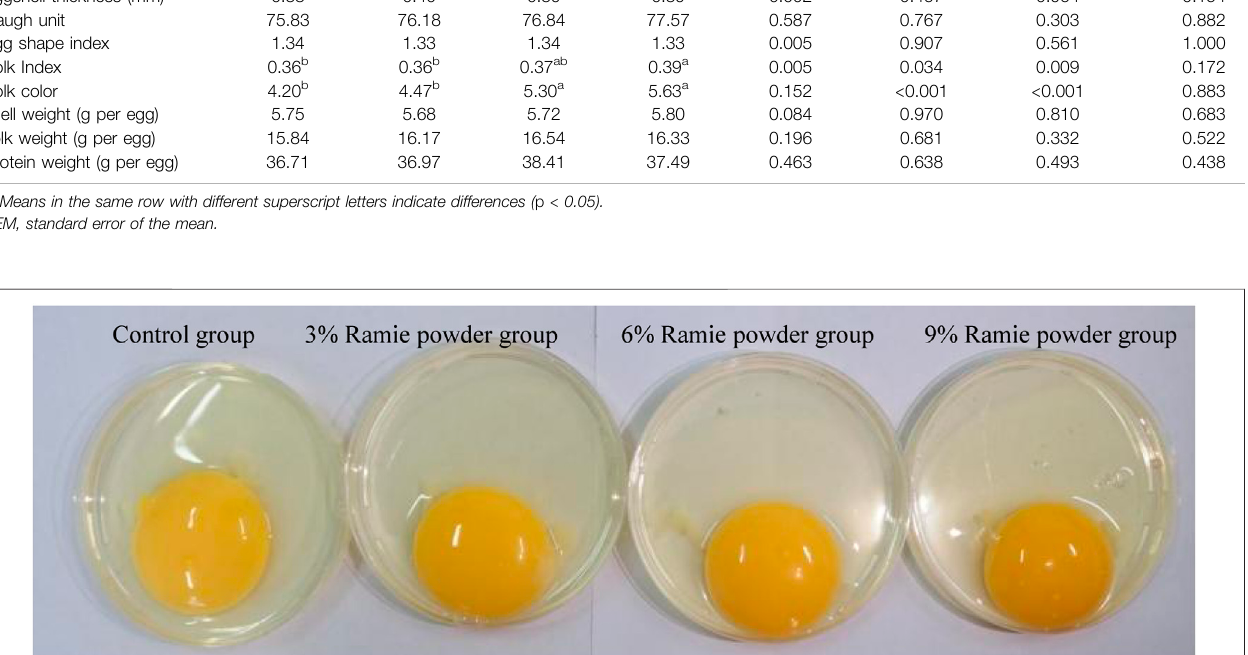
Frontiers in Physiology |